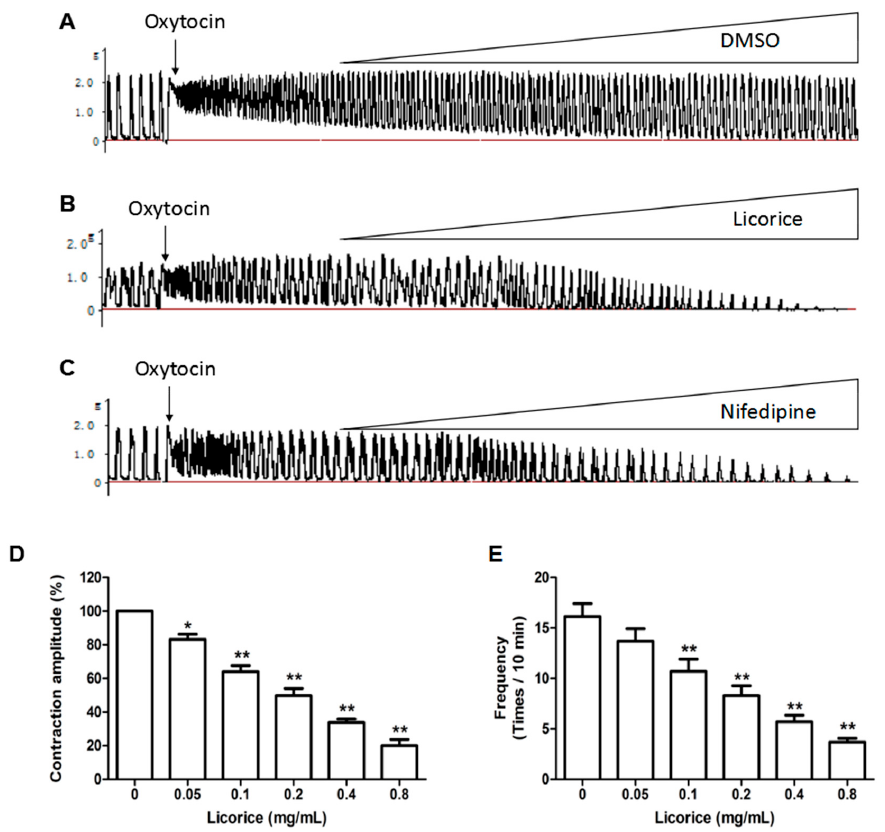
Figure 2. Effects of licorice aqueous extract on oxytocin-stimulated uterine contraction ex vivo: ( A